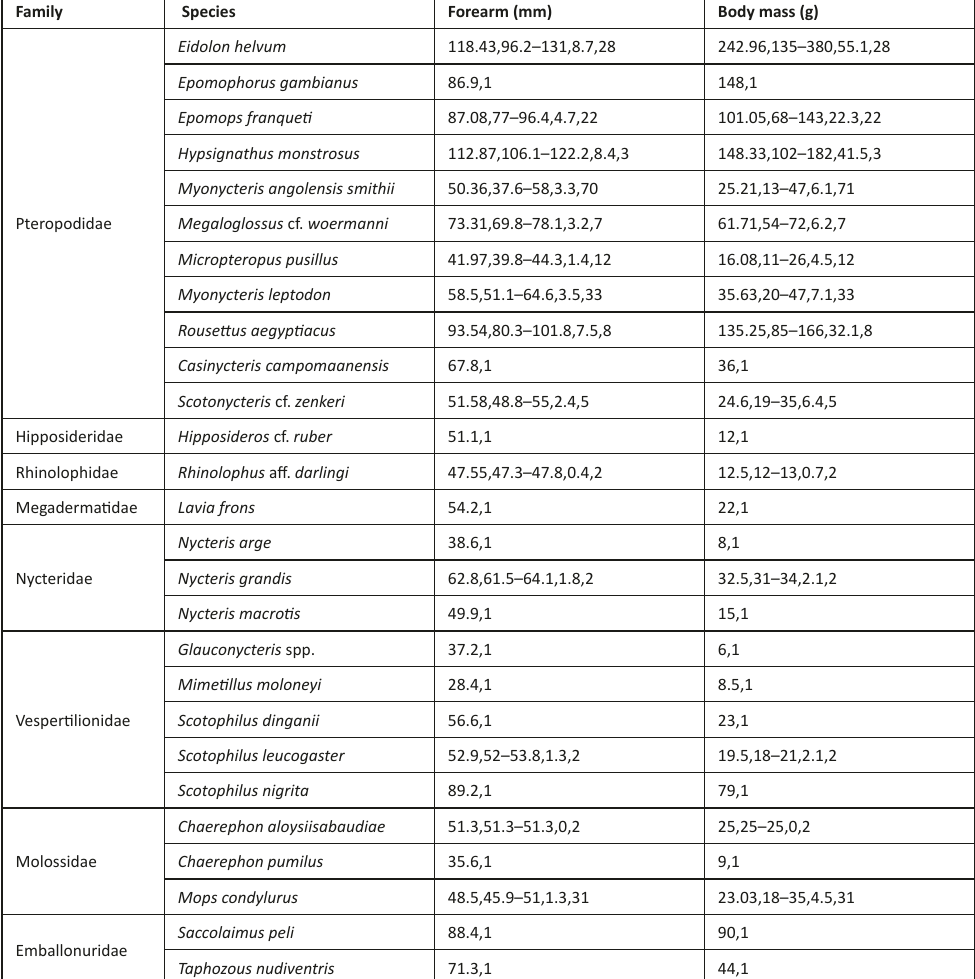
Table 2. Forearm length and body mass of 27 bat species captured during the survey. Values represent mean, range, standard deviation, and count.